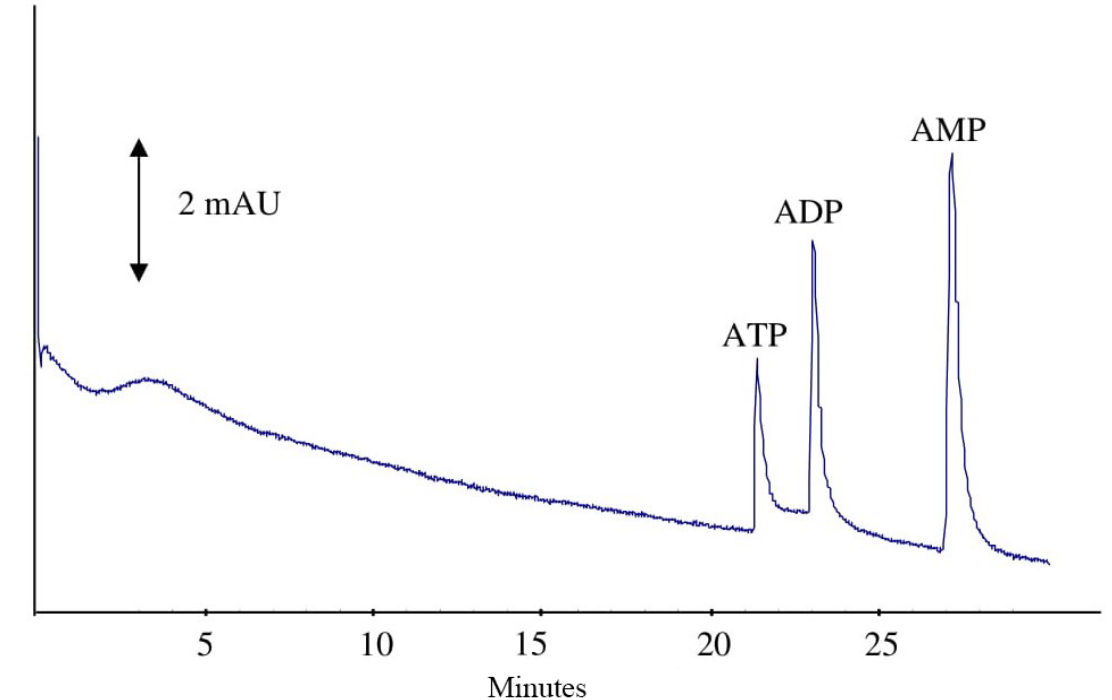
FIGURE 2 - Capillary electrophoresis (CE) separation of a 0.5 mM mixture of ATP, ADP, and AMP standards: 0.1 M tris buffer with 0.5 mM tetradecyltrimethylammonium chloride (TTAC) and 0.30 mg mL –1 hydroxypropylmethylcellulose (HPMC) with 50 µm i.d.x 63.5 (53.5) cm in length capillary at field strength of –236 V/cm and UV detection at 254